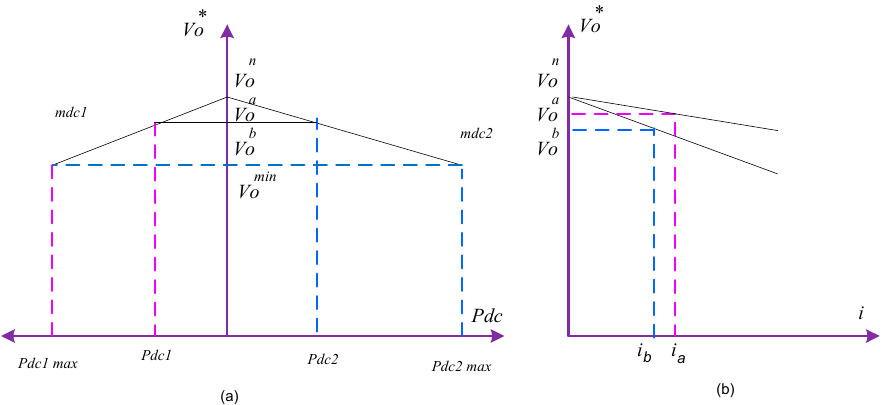
Figure 6. Representation of DC droop ( a ) The particular droop of two DG units; ( b ) v-I droop for the DC microgrid.